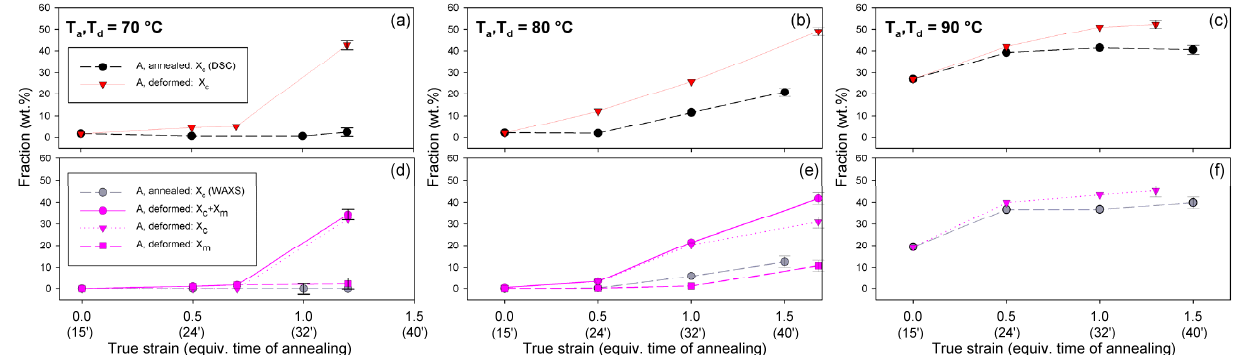
Figure 10. Phase composition (fraction of the crystalline phase and the mesophase) in A samples deformed by uniaxial drawing and the reference samples subjected to annealing at the respective temperature and time equivalent to the time of deformation. ( a – c ): composition determined from DSC; ( d – f ): composition estimated from X-ray diffractograms through peak fitting procedure. The temperature of deformation or annealing: 70 °C—( a , d ); 80 °C—( b , e ); and 90 °C—( c , f ).